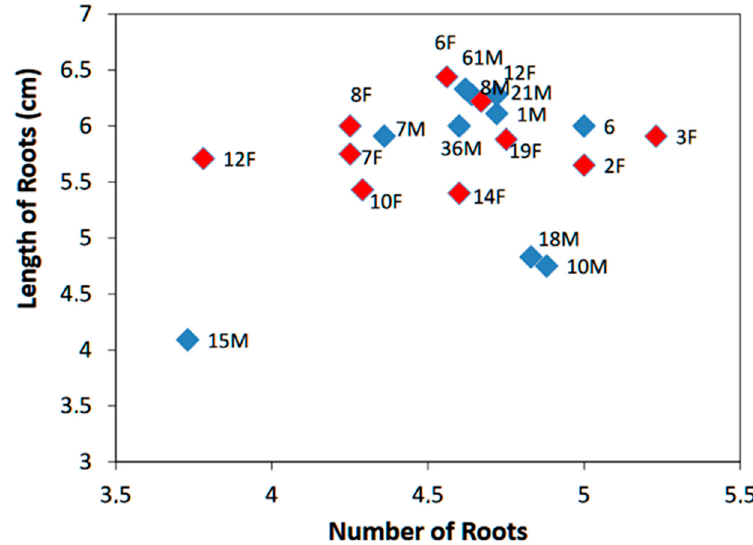
Figure 3. Cluster analysis of the number of roots (vertical) and length of roots (horizontal) of female (red) and male (blue) genotypes of P. lentiscus var. Chia shoot cuttings rooted in winter, with the application of 4 g · L − 1 K-IBA. The genotypes on the upper part and to the right are the most successful in rooting, as they form more and longer roots.